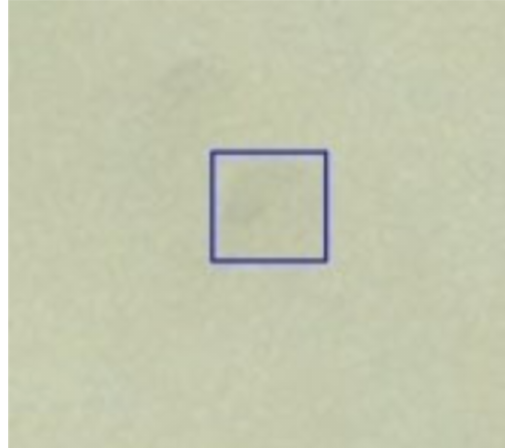
Figure 10. False positively detected nematode—due to a missing annotation: ( a ) annotated nematode image and ( b ) segmentation result.